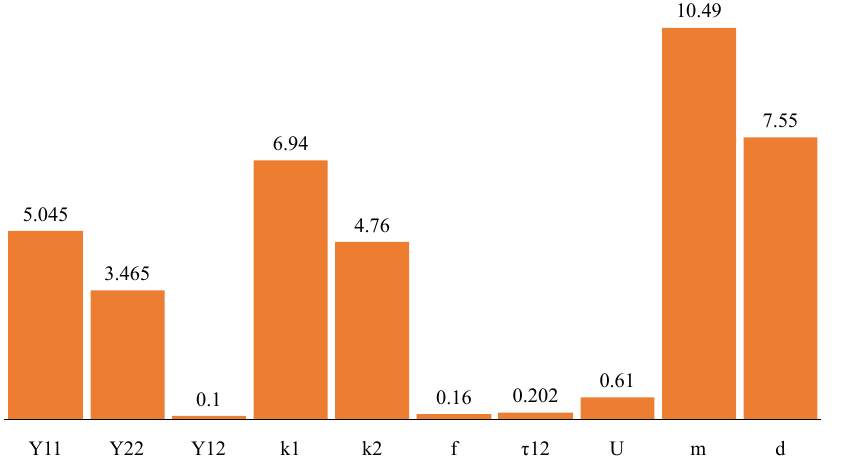
Figure 5. Dynamic characteristics of the external wall of the ventilated façade with the maximum layer thickness.